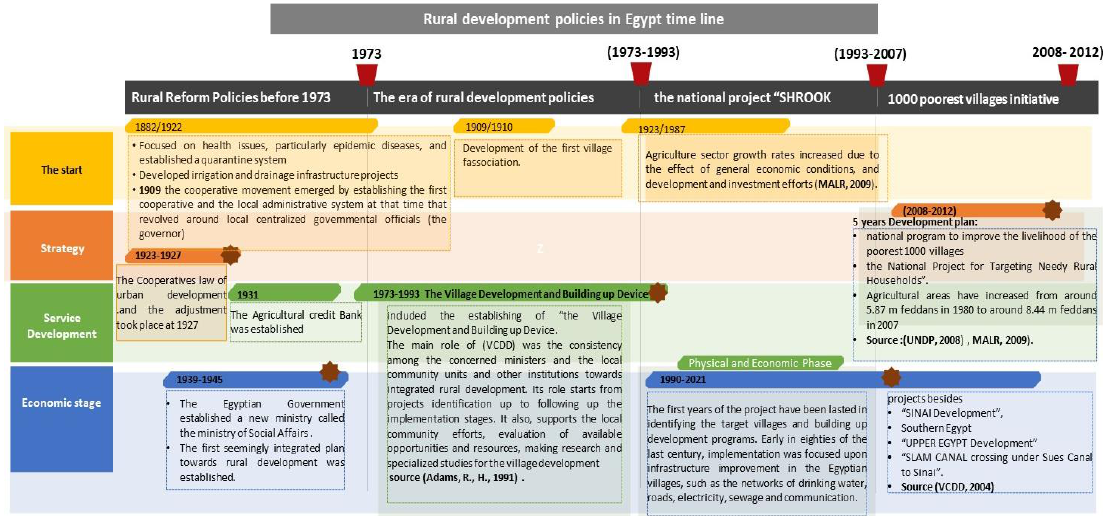
Figure 4 Timeline of rural development policies in Egypt Source: